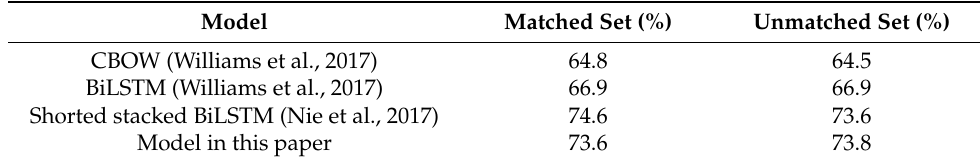
Table 4. Accuracy of each model on Multi-NLI